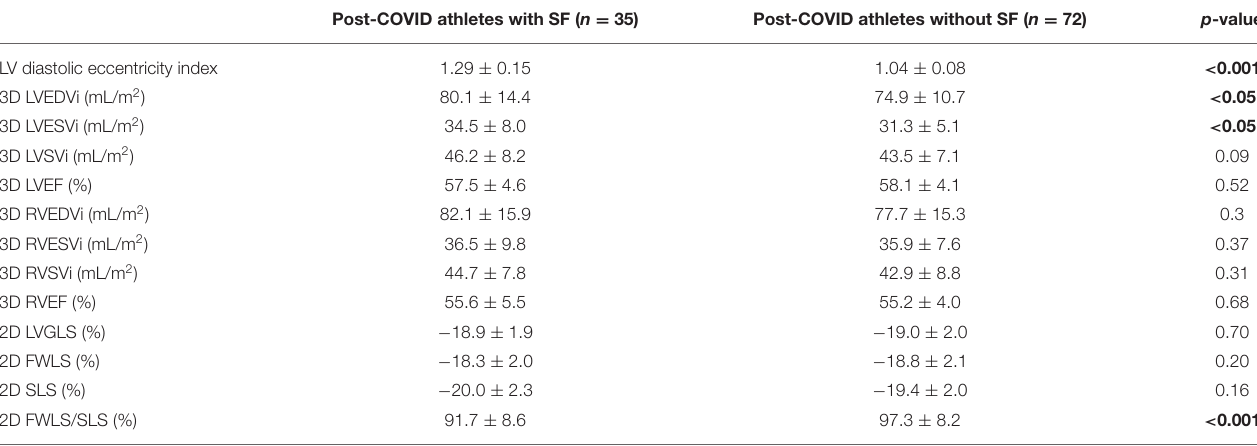
TABLE 4 | Echocardiographic comparison of post-COVID athletes with vs. without septal flattening. Post-COVID athletes with SF ( n = 35) Post-COVID athletes without SF ( n = 72)